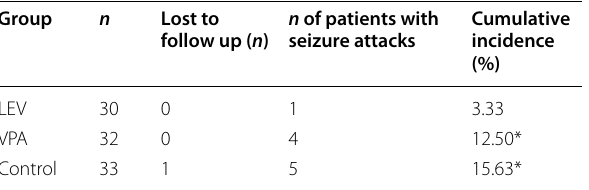
Table 2 Comparison of the cumulative incidences of LPTS in different